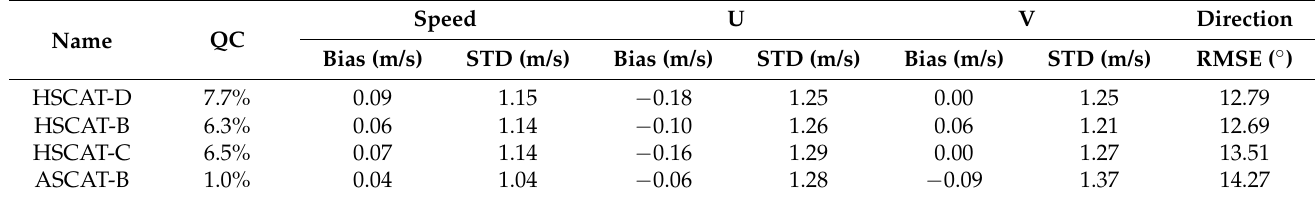
Table 3. Statistics of comparisons between scatterometer wind and ECMWF wind.